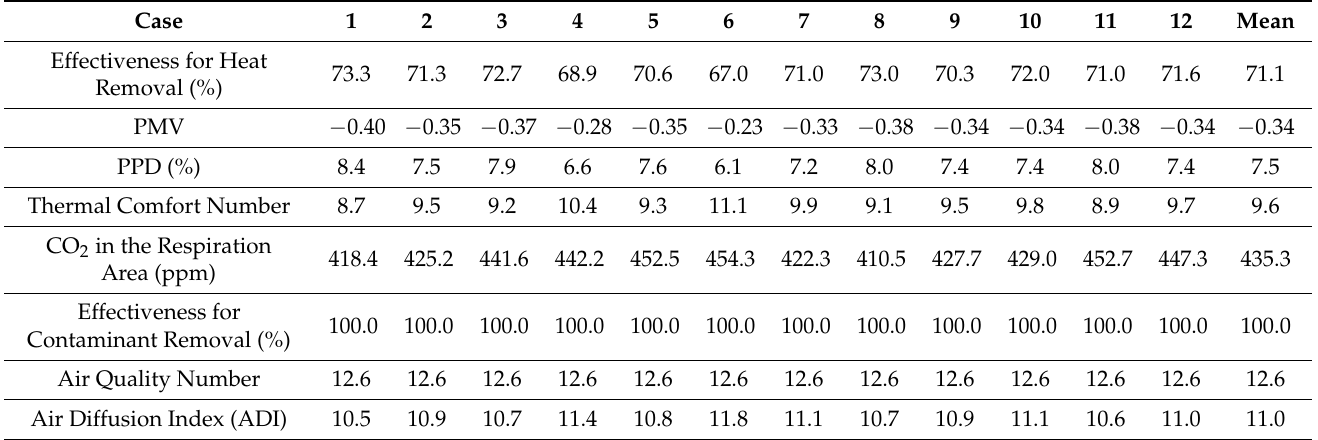
Table 13. ADI obtained for Case V (0.2333 m 3 /s) at 10 h.